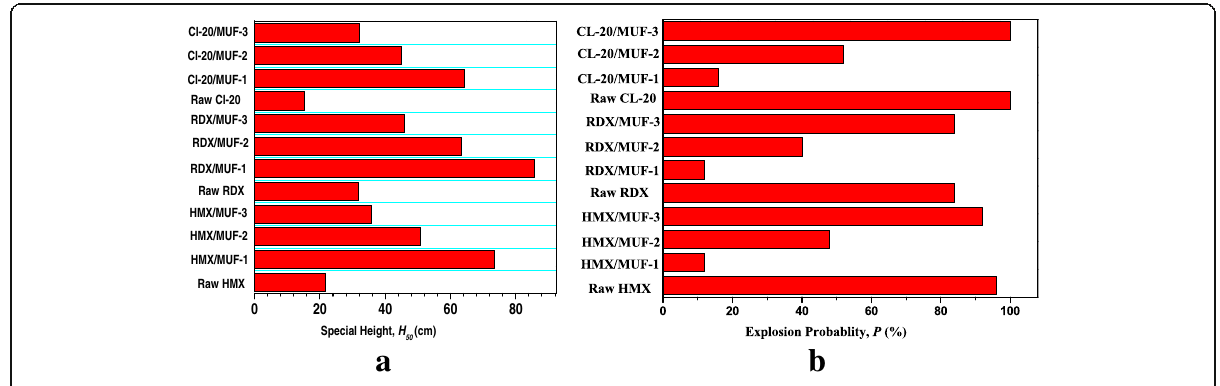
Fig. 8 Impact sensitivity of samples: a impact sensitivity and b friction sensitivity